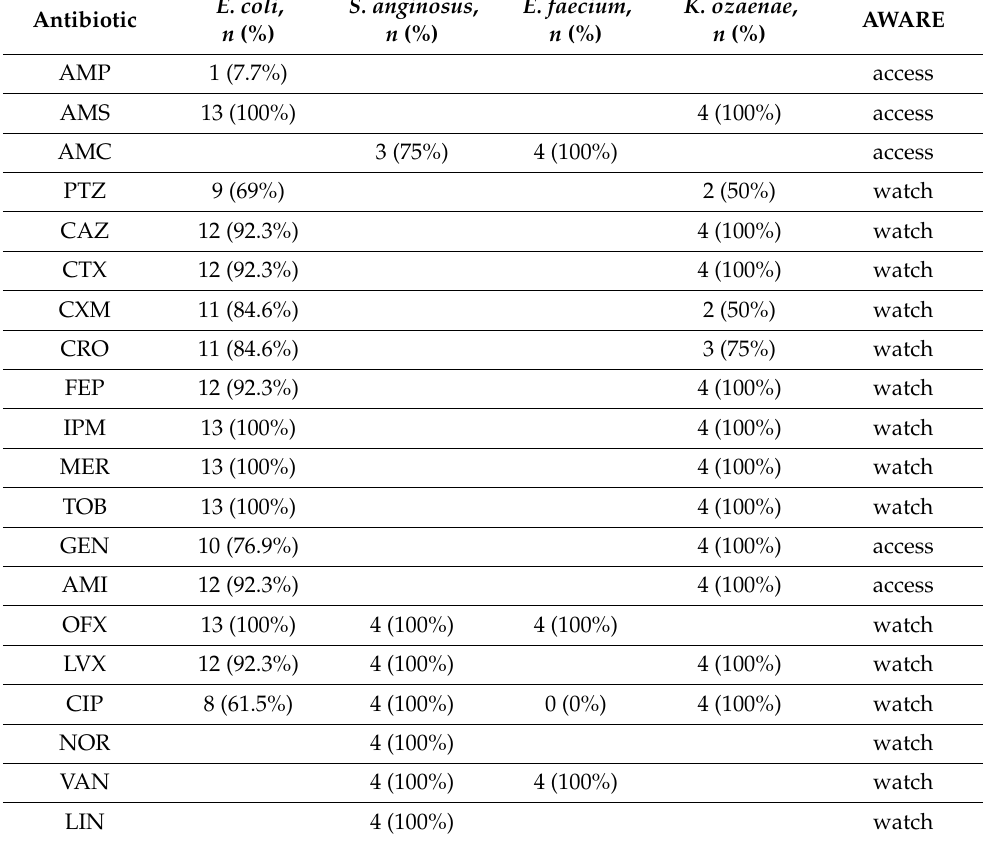
Table 2. Antibiotic sensitivity of the main strains of microorganisms isolated before stenting.